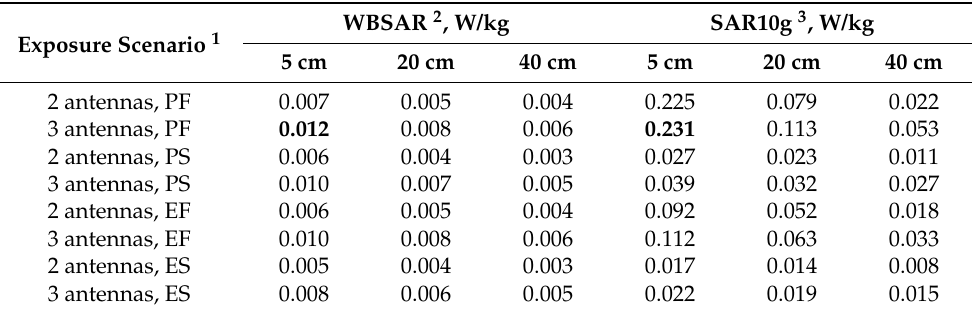
Table 2. SAR values in the human body model Duke for various exposure scenarios, at 5, 20 and 40 cm to UHF RFID antennas for an input power to each antenna of 1 W @ 866